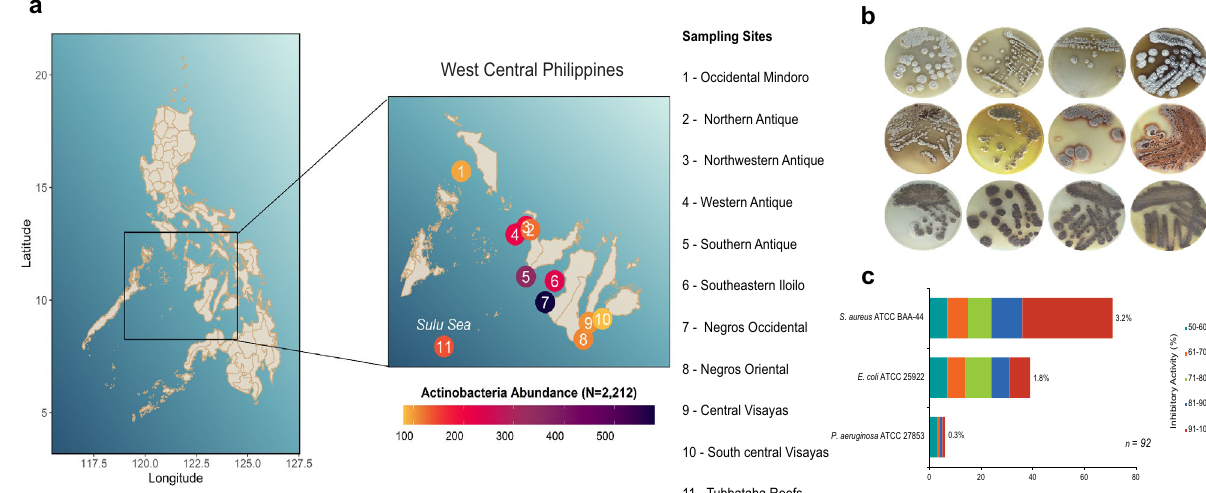
Figure 1. Distribution, abundance, and antibacterial activity of marine sediment-derived actinomycetes in the Philippines. ( a ) The overall map showing the 11 sampling sites situated within the west-central region in the Philippines. The enlarged map showed the details of the sampling sites and their corresponding actinomycetes abundance. Sampling sites are number-coded as shown inside the circle. The color gradient indicates strain abundance. ( b ) Actinomycete colonies were sub-cultured repeatedly to obtain pure culture of isolates. ( c ) A total of 92 out of 2212 actinomycetes strains have confirmed antibacterial activities as verified using microbroth susceptibility assay. The map with Streptomyces abundance plot was generated using ggplot2 package in Rstudio ver. 1.2.5042 (https:// www. rstud io.